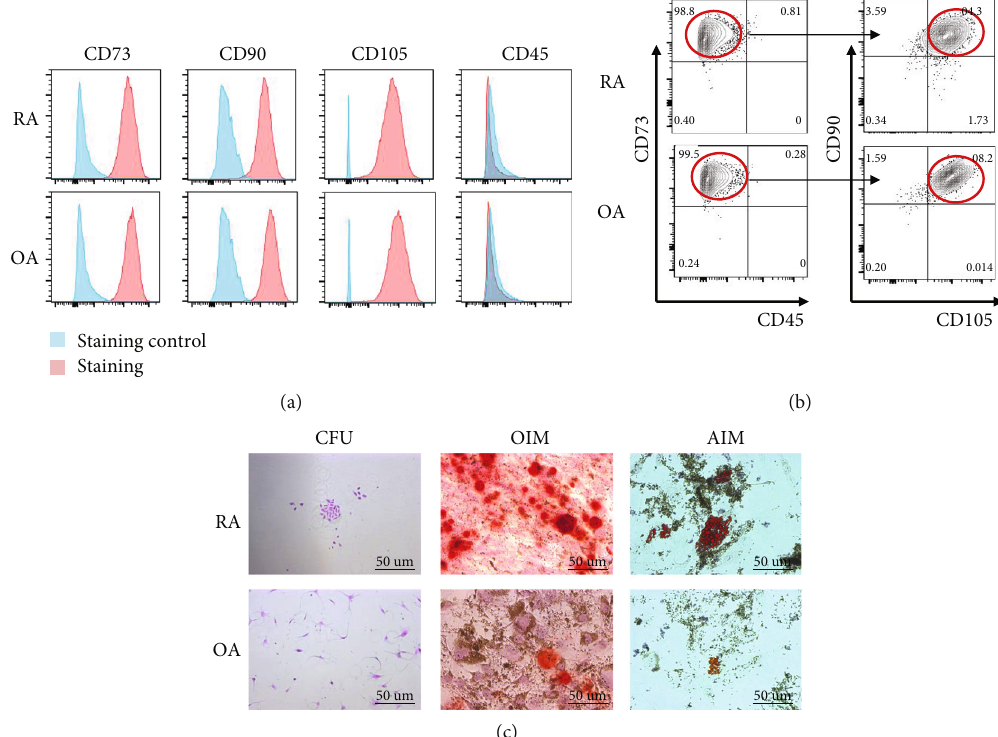
Figure 1: RA-FLSs show a MSC-like phenotype and are able to di ff erentiate into osteoblasts or adipocytes. (a) Surface antigen pro fi les of RA-FLSs and OA-FLSs. The red line represents the speci fi c antibody while the blue line represents the isotype control. (b) Analysis of the surface antigens with FlowJo software. (c) Crystal violet staining of RA-FLSs and OA-FLSs after culture for 14 days under normoxic condition. Alizarin Red staining of RA-FLSs and OA-FLSs after culture in OIM for 21 days under normoxic condition. Oil Red O staining of RA-FLSs and OA-FLSs after culture in AIM for 21 days under normoxic condition. All experiments were repeated three times. CFU: cell formation unit; OIM: osteogenic induction medium; AIM: adipogenic induction medium. Scale bars: C = 50 μ m